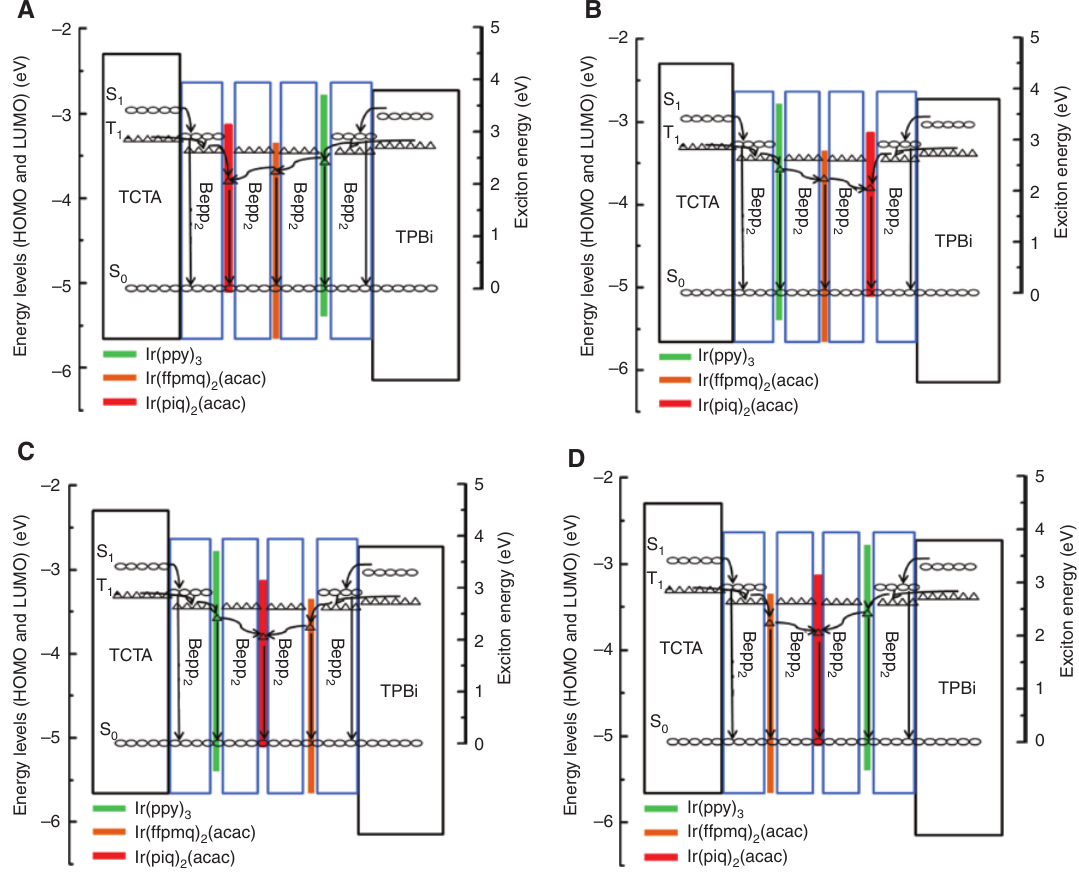
Figure 5: Schematic diagrams of the emission mechanisms of four white devices. (A) For device W1, (B) for device W2, (C) for device W3, (D) for device W4. The circles and triangles are the exciton energies (S1, S0, and